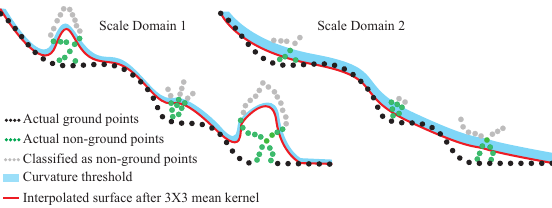
Figure 5. Sketch of multiscale curvature classification